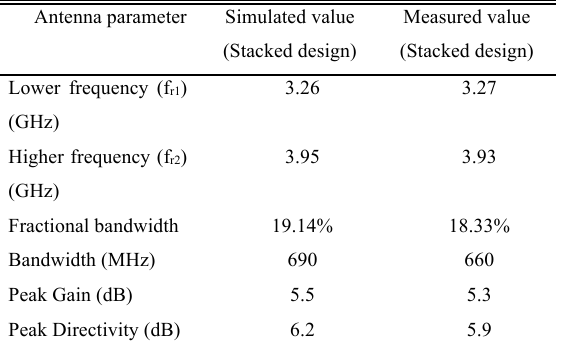
TABLE VI. Simulated and measured results of PAR with DSLFSS.